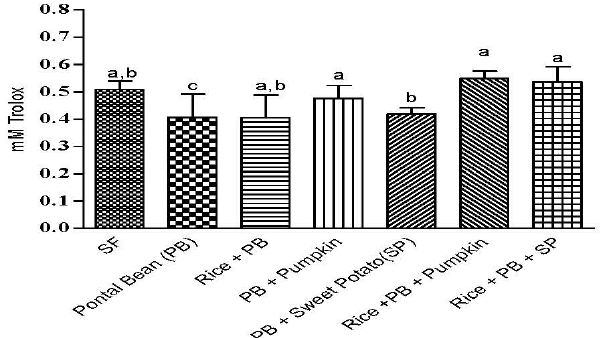
Figure 3. Plasma Total Antioxidant capacity. Results are expressed in mM Trolox equivalent. FS: Sulfate Ferrous; PB: Pontal Bean; PB + R: Pontal Bean + Rice; PB + P: Pontal Bean + Pumpkin; PB + SP: Pontal Bean + Sweet Potato; PB + R + P: Pontal Bean + Rice + Pumpkin; PB + R + SP: Pontal Bean + Rice + Sweet Potato. Different letters indicate statistical differences at 5% probability by Duncan test.